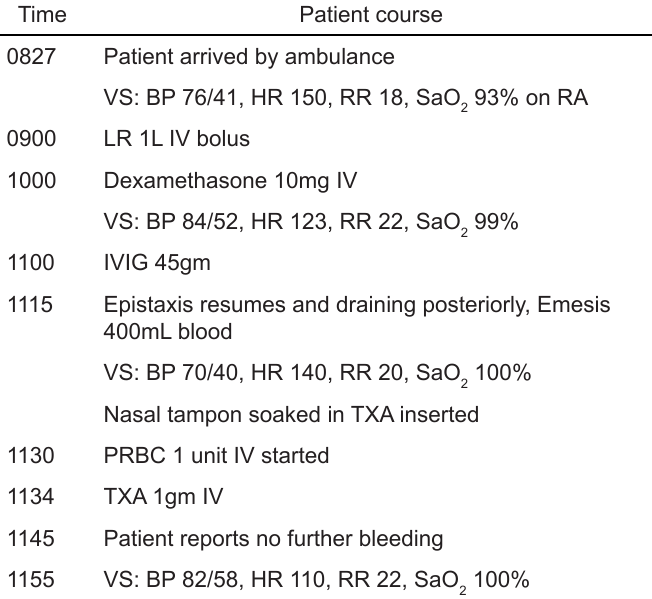
Table. Timeline of patient